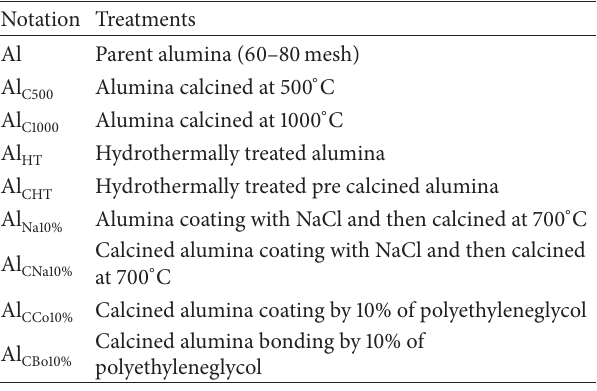
Table 1: Notation of the prepared